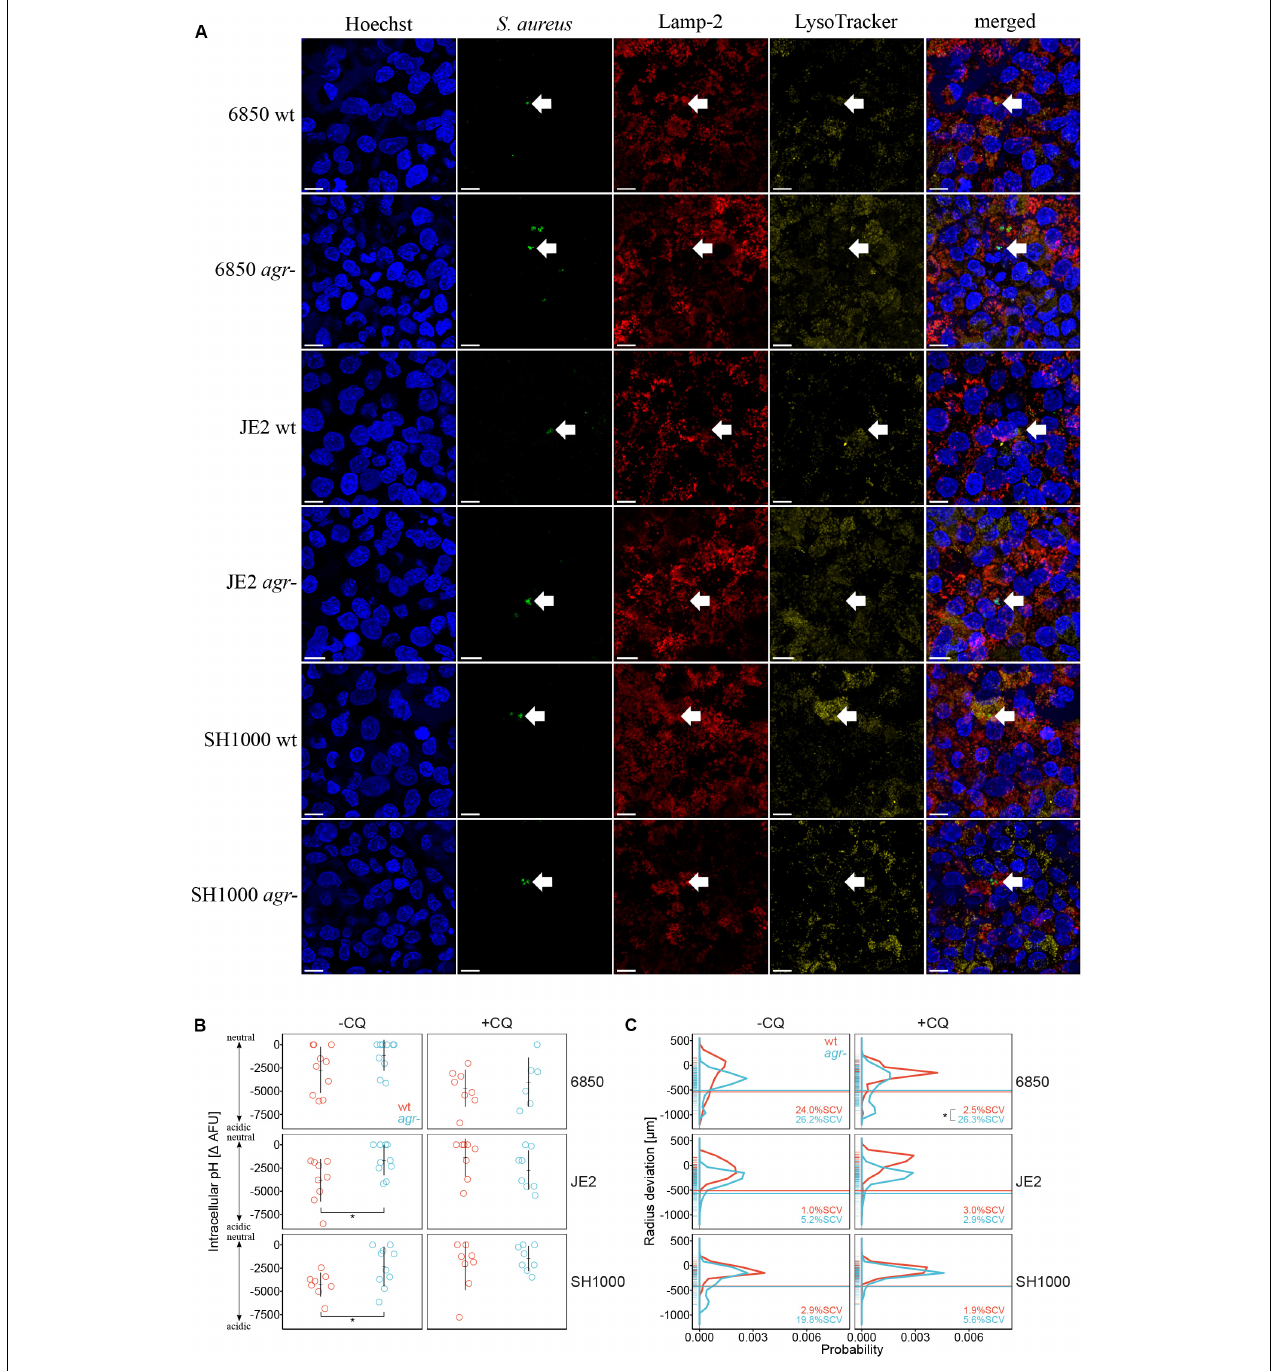
FIGURE 3 | Acidic intracellular pH triggers SCV formation in S. aureus wild type strains. S. aureus wild type strains (wt) are indicated in red, agr mutants ( agr -) are indicated in blue. (A) Intracellular localization of S. aureus strains 5 days after infection shown by arrows. Co-localization of S. aureus wild type strains with Lamp-2 and LysoTracker indicate the localization in acidic endosomes. Length of scale bar is 10 µ m. (B) Measurement of intracellular pH after 5 days of infection. The alkalizing agent chloroquine (CQ) was used to neutralize phagolysosomes. − CQ indicates no treatment, +CQ indicates chloroquine treatment. Eight to ten independent experiments in technical triplicates ± SEM are shown. Pairwise comparison of JE2 wt and agr- * p = 0.0243, pairwise comparison of SH1000 wt and agr- * p = 0.0486. (C) Comparison of colony size distribution of untreated ( − CQ) and chloroquine treated (+CQ) bacteria recovered after 5 days of infection. After 24 h regrowth, colony radius is normalized to the strain specific mean colony area at day 0 ( Supplementary Figure 1 ). Radius size deviation from reference is plotted as probability. The threshold for SCVs, indicated as a horizontal line, was calculated as 1/5th of the area of the median area at day 0. The mean percentage of SCVs is written in each panel. Colonies from single images as well as from time-lapse analysis were taken into account. Colony radius deviation of untreated bacteria is also shown in Figure 2B . In total 9,381 colonies (4,387 untreated and 4,994 chloroquine treated) in two to five biological repeats were analyzed. * p = 0.0209.